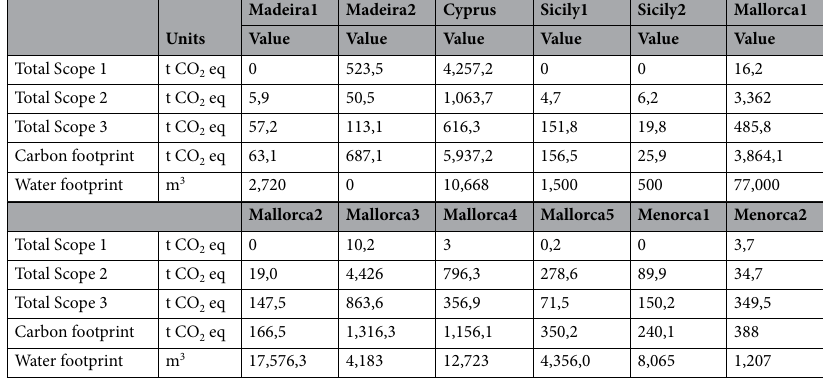
Table 2. Results of the carbon and water footprints of the 12 European marinas analysed.